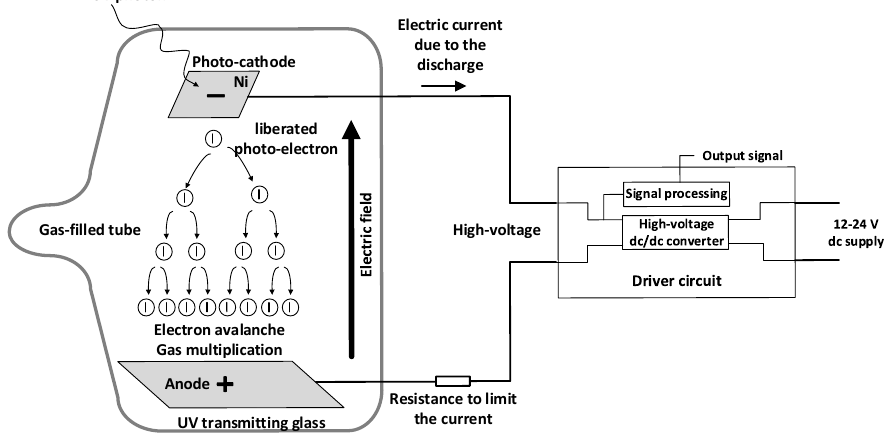
Figure 1. Schematics of a gas-filled tube to multiply the liberated photo-electrons by the incident UV photons and the driver circuit.